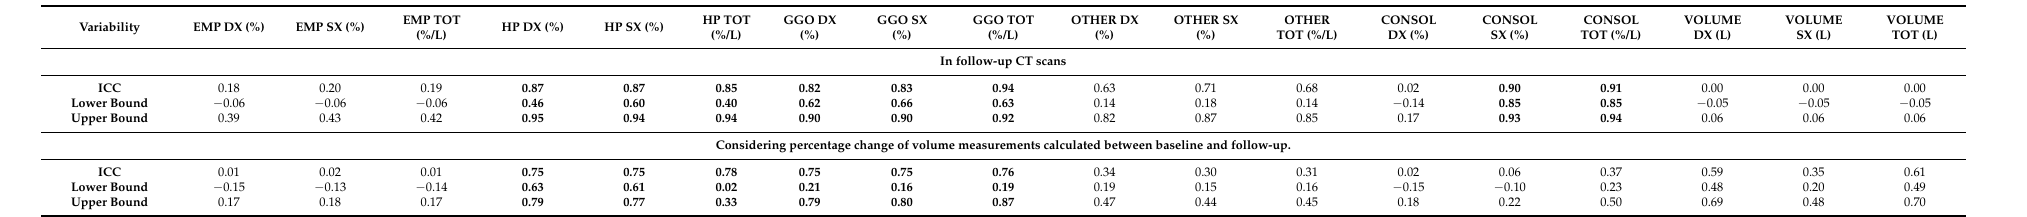
Table 3. The intraclass coefficient (ICC) among quantitative volumes obtained using different commercial computerized tools on follow-up CT scans. Variability